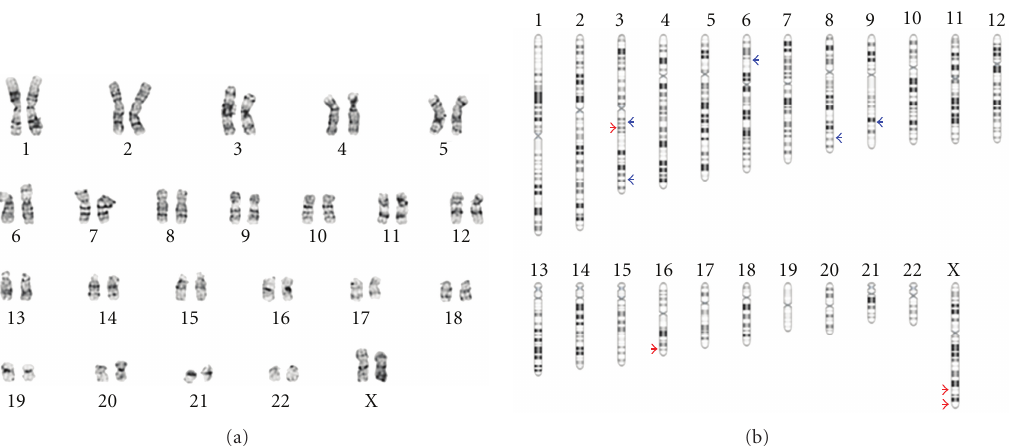
Figure 3: Genomic stability profiling of a human iPSC line by karyotype analysis and the StemArray. (a) The majority of stem cell researchers still characterize their cells by G-banding metaphase karyotyping which has a resolution of only 5Mb. Testing our iPSC line with this method did not detect any aberrations. (b) aCGH with the custom 135 K microarray identified 4 deletions and 5 amplifications in the iPSC sample ranging in size from 1.5Kb to 595 Kb.